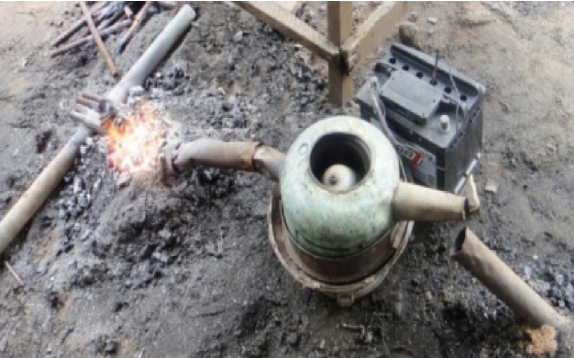
Figure 1 | Automobile Battery operated forge. Photograph by Kingsley O. Emeriewen, 2012.